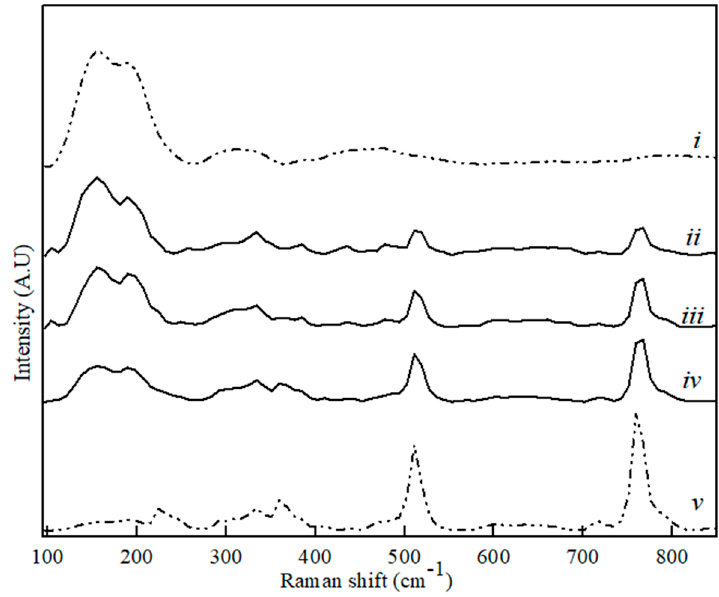
Figure 7. Raman spectra for CaS ( i ), C3A ( v ) and binary CaS–C3A phase sample with CaS content, where ( ii ) 80 wt. %, ( iii ) 60 wt. %, and ( iv ) 20 wt. %.